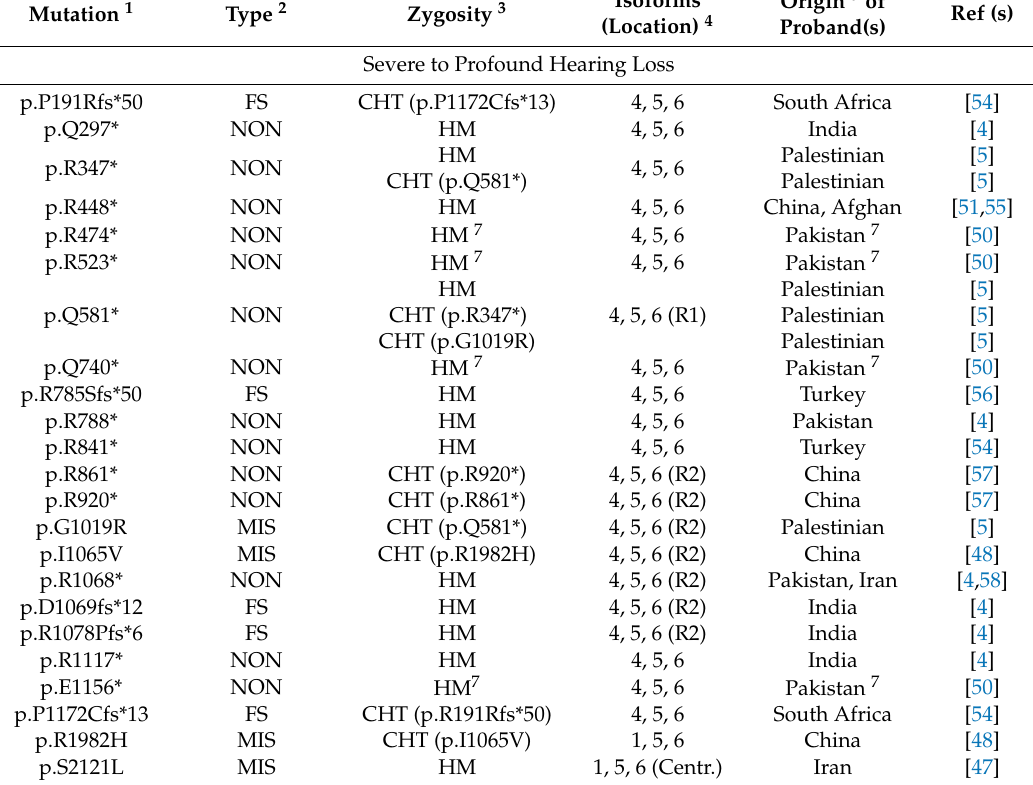
Table 1. Published mutations in TRIOBP from individuals and families with hearing